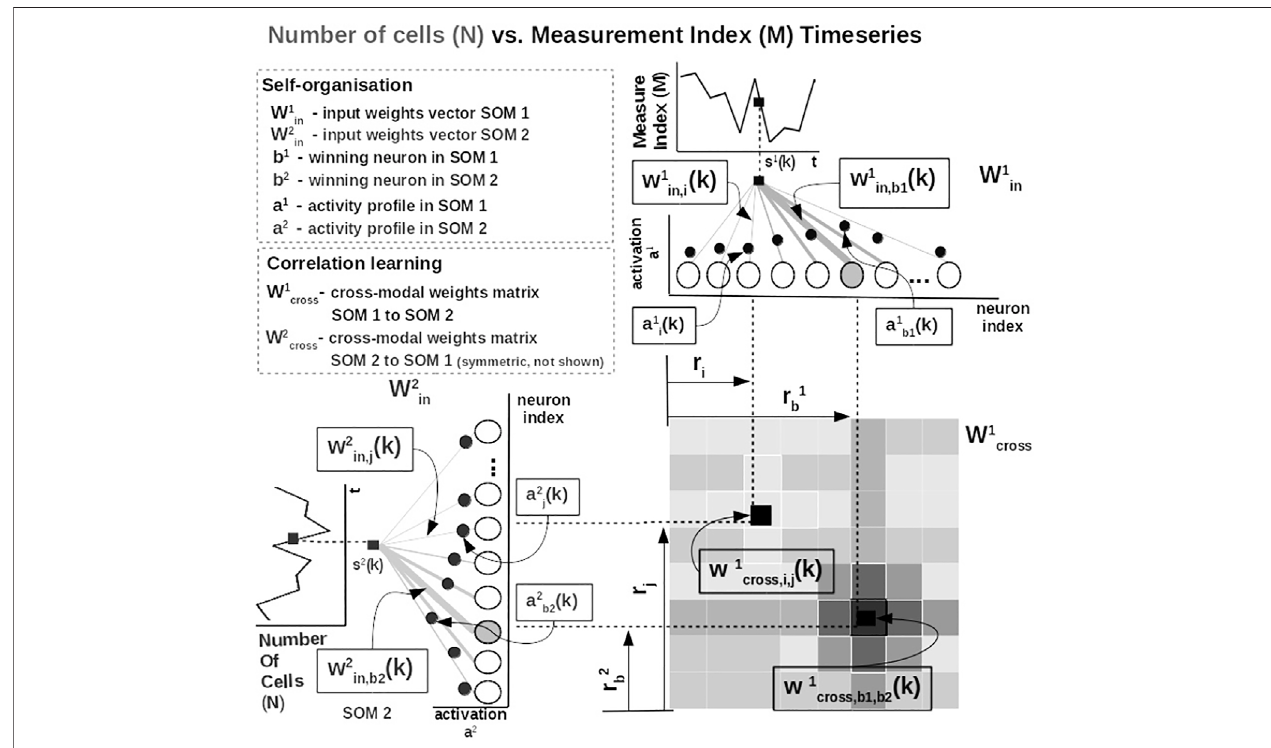
FIGURE3| Detailedcomputationalstepsofoursystem,instantiatedfortumorgrowthlearninggiventheobservednumberofcellsandthemeasurementindexdata from Comen et al. (2016).